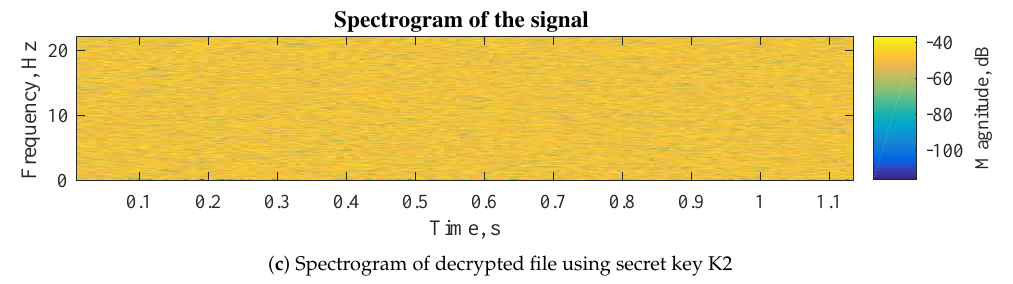
Figure 9. Spectrogram plotting-key sensitivity.